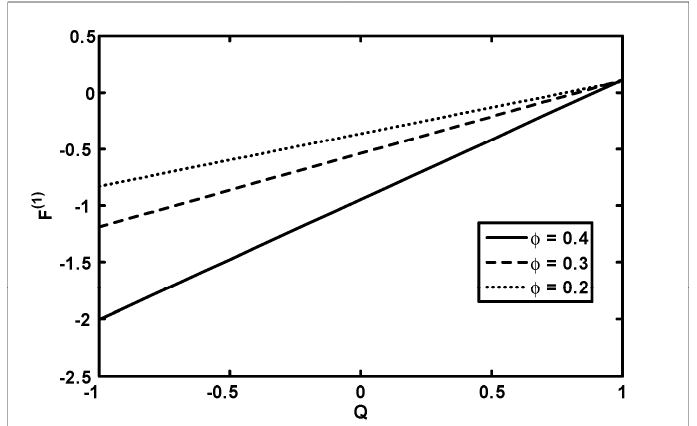
Figure 7. The variation of friction force F ( 0 ) (outer tube) with Q for di ff erent values of φ at r 1 = 0.1, M = 3, when µ = r .